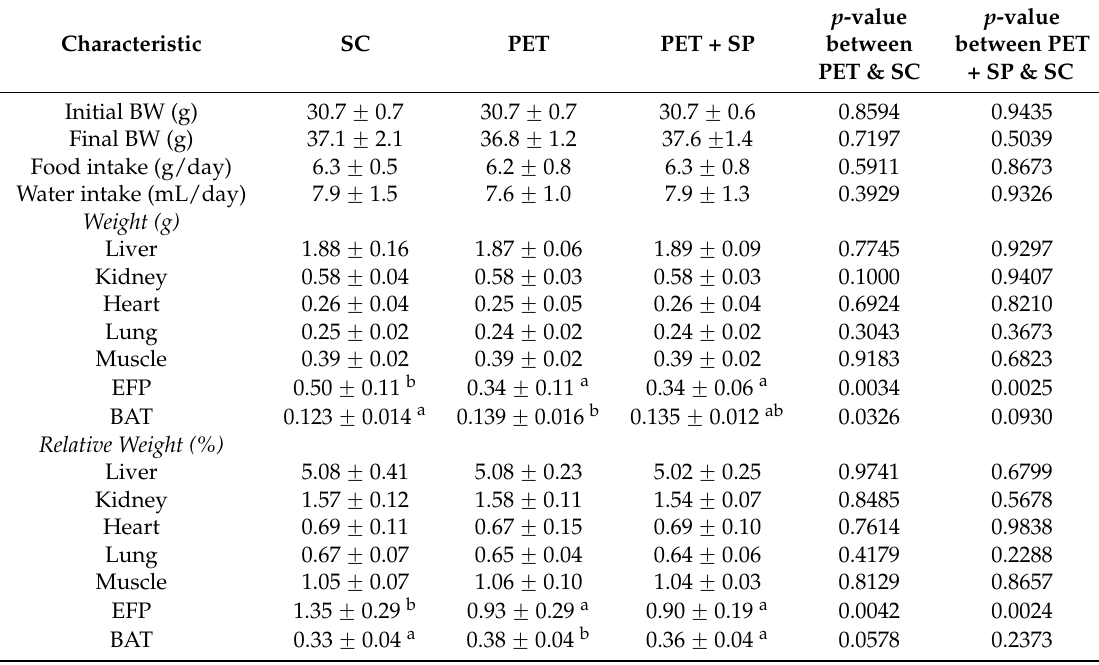
Table 2. General characteristics of the experimental